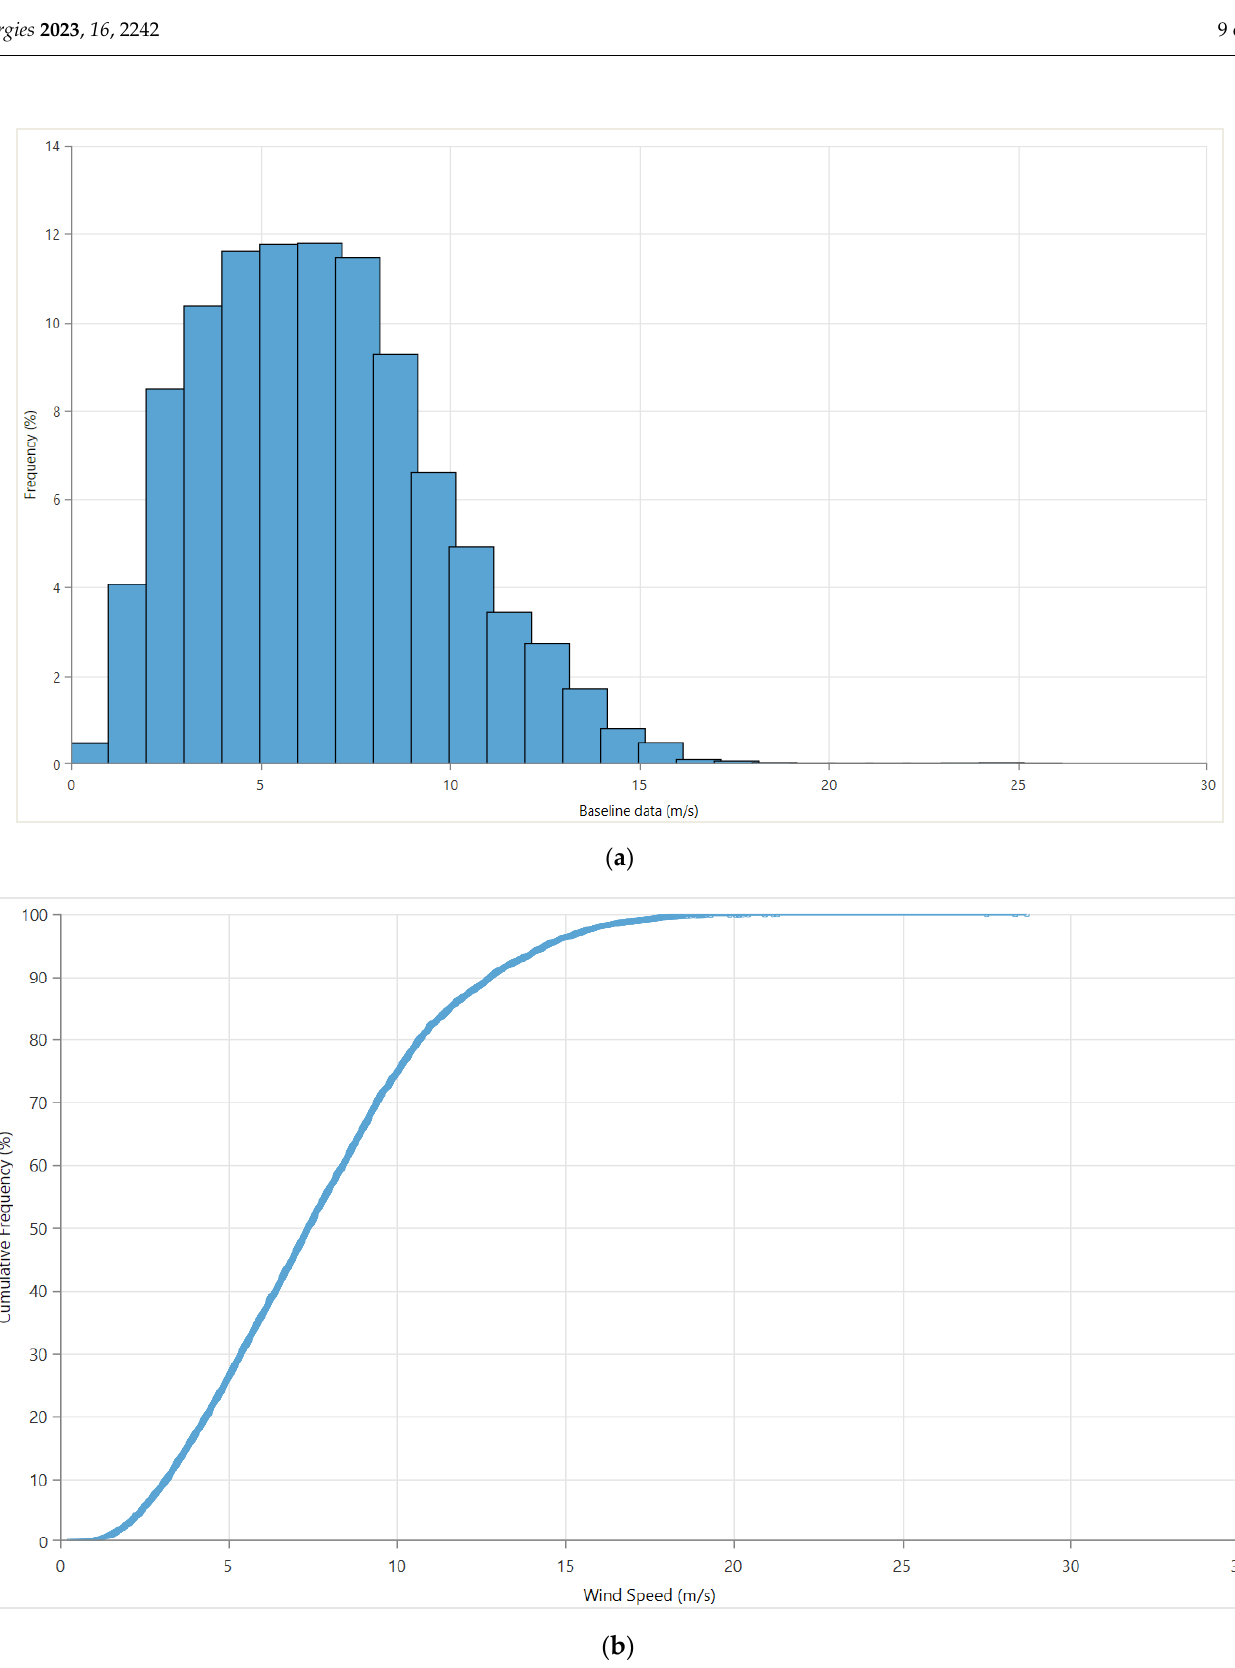
Figure 5. ( a ) Wind Data Histogram and ( b ) Cumulative Distribution Function .